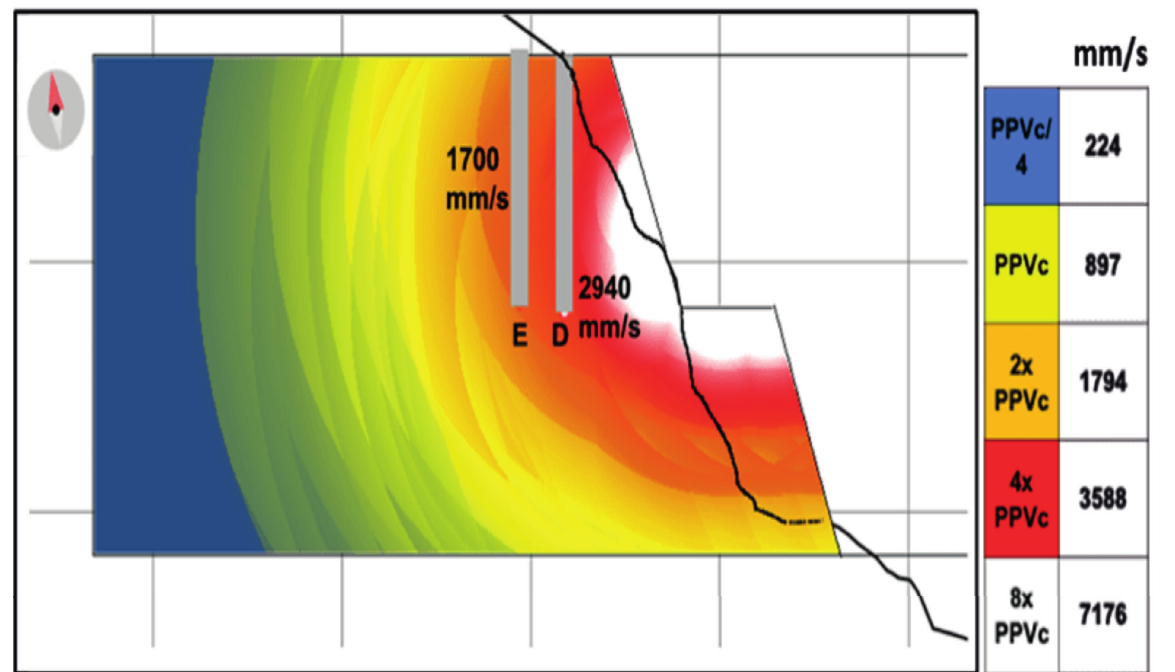
Figure 9. Vibration heat map showing the inspected holes in gray, expected induced damage based on PPVc and the actual slope in black for blast test 2. Fracturing is expected throughout the yellow zone and the distance between the last row of boreholes until its border is around 21